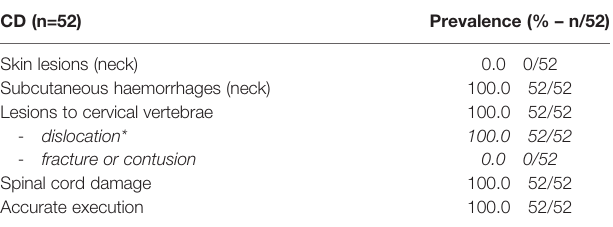
TABLE 4 | Summary of the post-mortem examination after cervical dislocation (CD) in Effectiveness and Animal Welfare Study, with the prevalence (in % and ratio) of injuries speci fi c for CD, and decision on the accuracy of execution of the killing method. CD